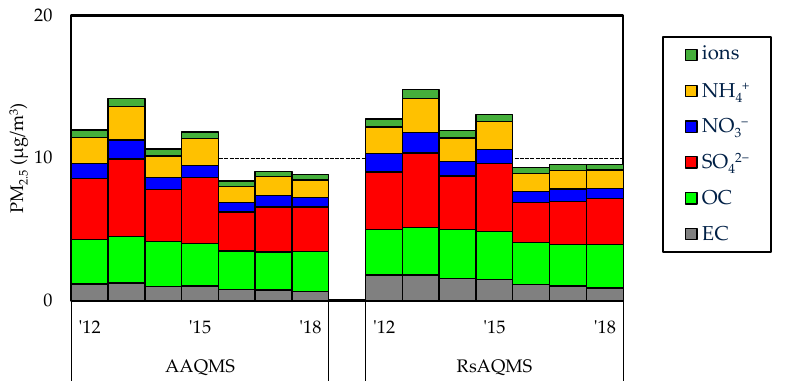
Figure 3. Annual average concentration of main components in PM 2.5 (AAQMS, RsAQMS) for 2012–2018. Table 3. Annual average concentration of main components in PM 2.5 (AAQMS, RsAQMS) for 2012, 2015 and 2018, and the concentration ratios in 2018 relative to 2012. PM 2.5